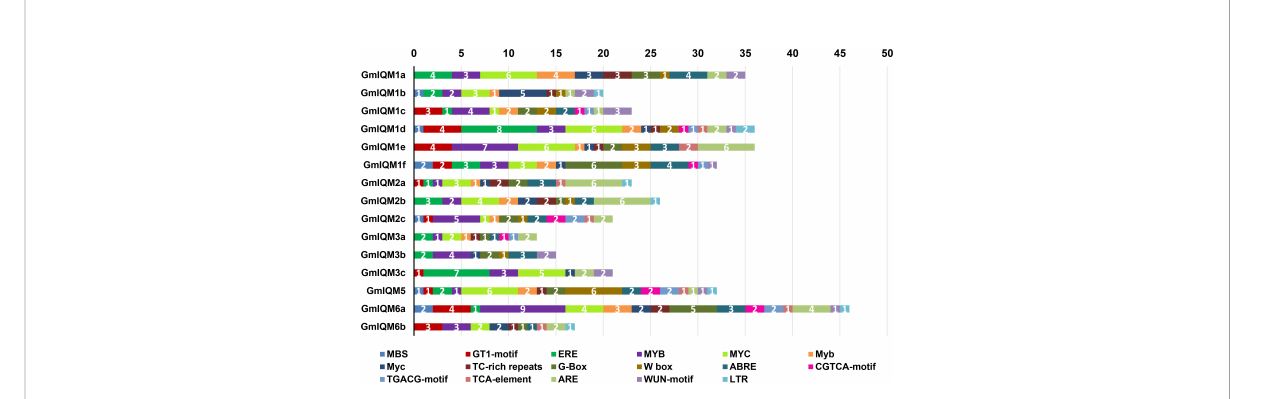
FIGURE 8 Putative cis -acting elements of the IQM promoters predicted by PlantCARE.The different cis -elements are indicated by different colors. The numbers on the box represent the count of cis -elements in the